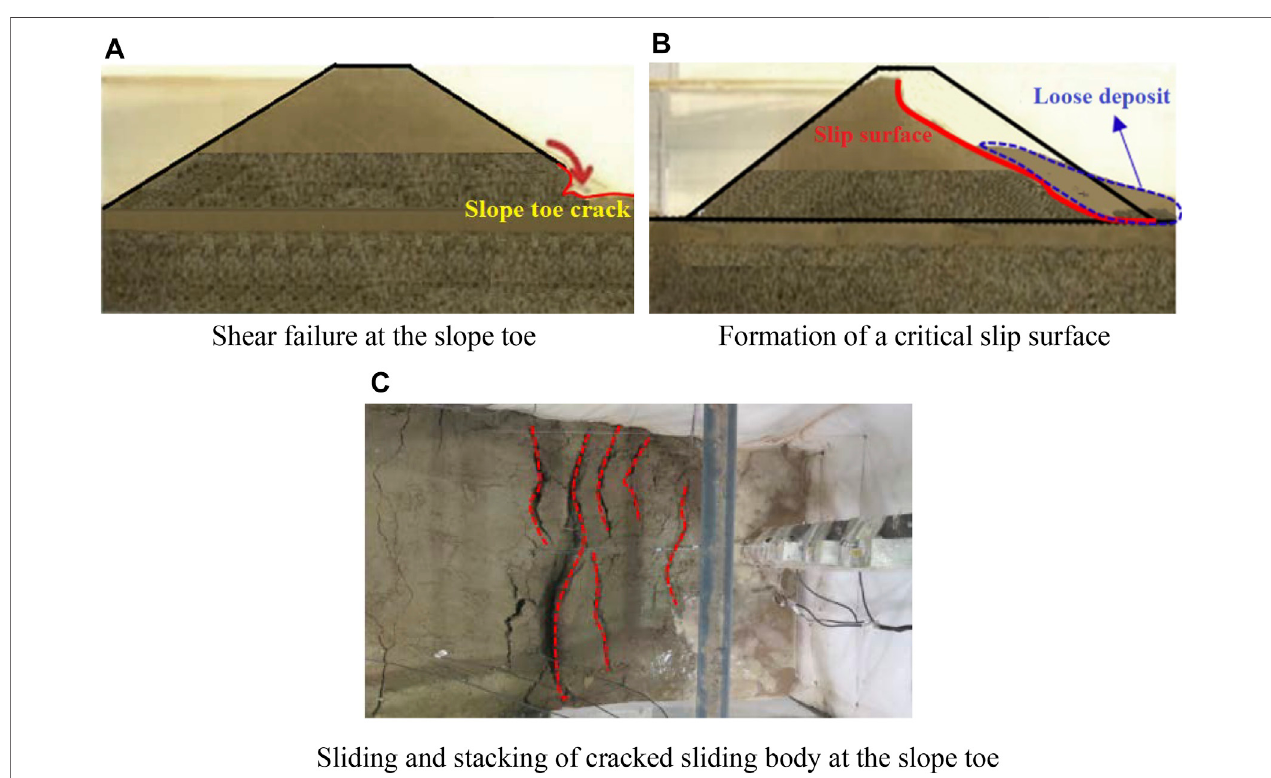
FIGURE 16 | Formation process of the critical slip surface at the slope toe. (A) Shear failure at the slope toe. (B) Formation of a critical slip surface. (C) Sliding and stacking of a cracked sliding body at the slope toe.